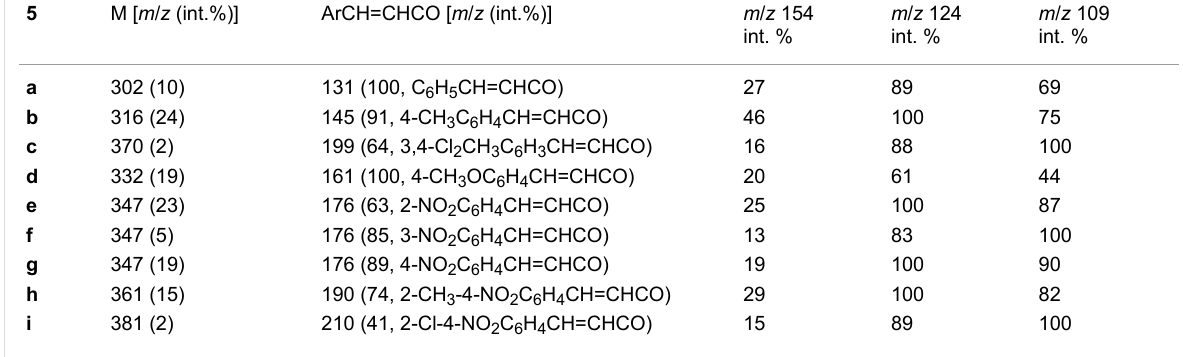
Table 3: The relative intensities of the molecular, cinnamic acyl, m / z 154, m / z 124, and m / z 109 ions. 5 M [ m / z